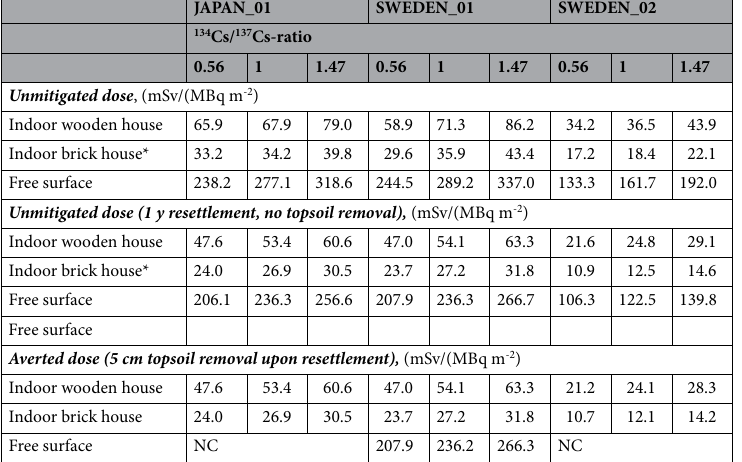
Table 3. Unmitigated 50 y effective dose per unit 137 Cs deposition, E (mSv/(MBq m −2 137 Cs) from residential garden surfaces for three types of soil migration settings (see Table 2), to residents in wooden or brick houses in the modeled urban area (excluding short-lived fission products) and the corresponding averted dose (integrated over 50 y) after a combination of evacuation prior to resettlement at time t cleanup = 1 y and subsequent 5 cm topsoil removal from an NPP release with 134 Cs/ 137 Cs ratios of 0.56, 1, and 1.47. NC = Not computed.